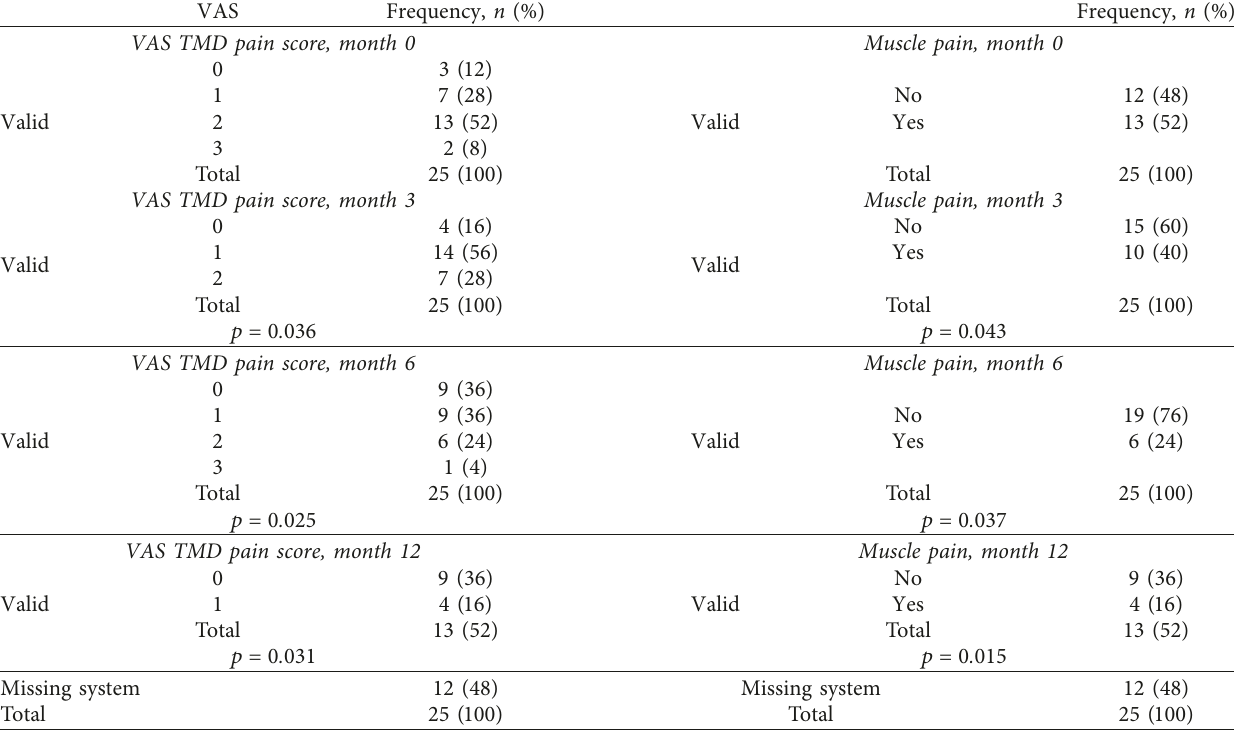
Table 3: Statistic calculation of the patient’s variables including TMD pain and muscle pain during the treatment period. VAS Frequency, n (%) Frequency, n (%) VAS TMD pain score, month 0 Muscle pain, month 0